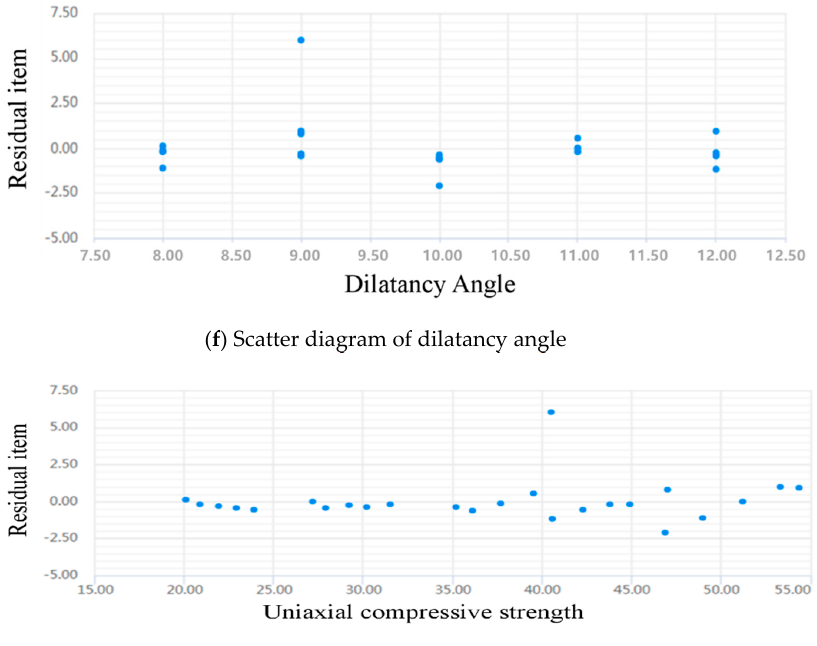
Figure 20. Scatter diagram of related variables and residuals in the regression model.